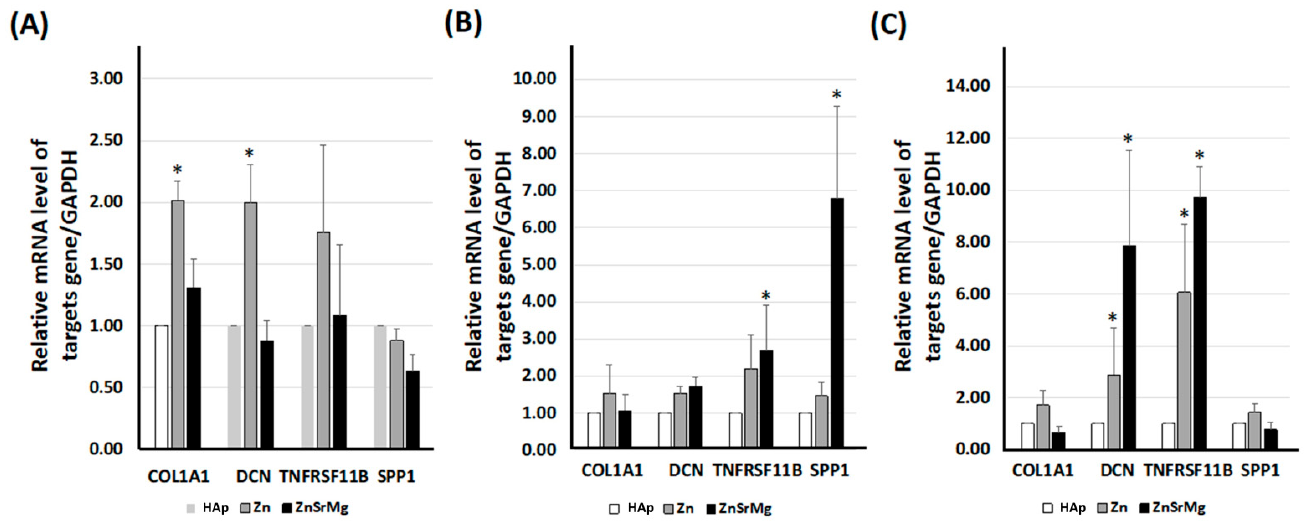
Figure 1. Expression of osteointegration-associated gene expression in HEPM. The HEPM cells were incubated on titanium discs coated with HAp, Zn-HAp, or ZnSrMg-HAp for 3 ( A ), 7 ( B ), and 11 days ( C ). Purified cellular mRNA was applied for a qPCR assay with primer sets of COL1A1, DCN, TNFRSF11B, and SPP1. * p < 0.05 vs. HAp group.